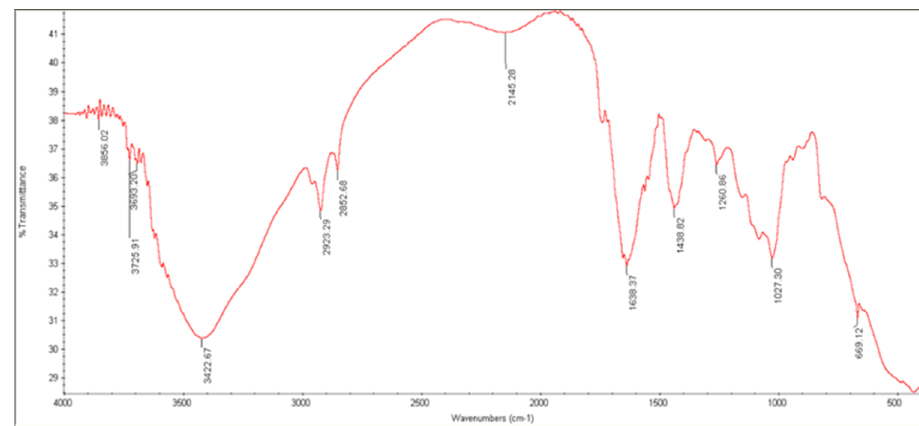
Figure 5. FTIR spectra of ALG–AG complex. Table 2. Positions of main FTIR stretching bands and their relative assignments for ALG, AG and ALG–AG complex .